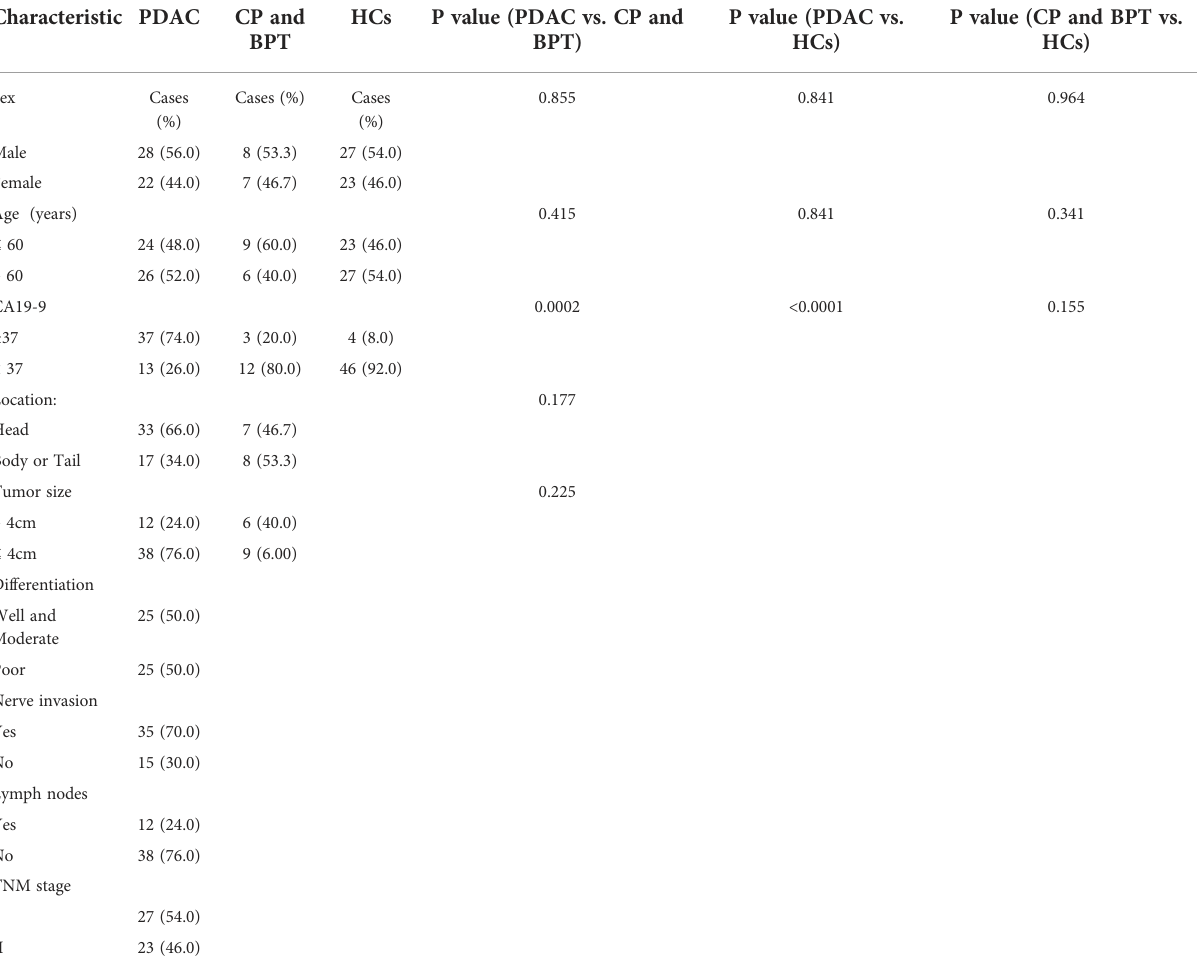
Table 1 Characteristics of patients and healthy controls enrolled in the study. Characteristic